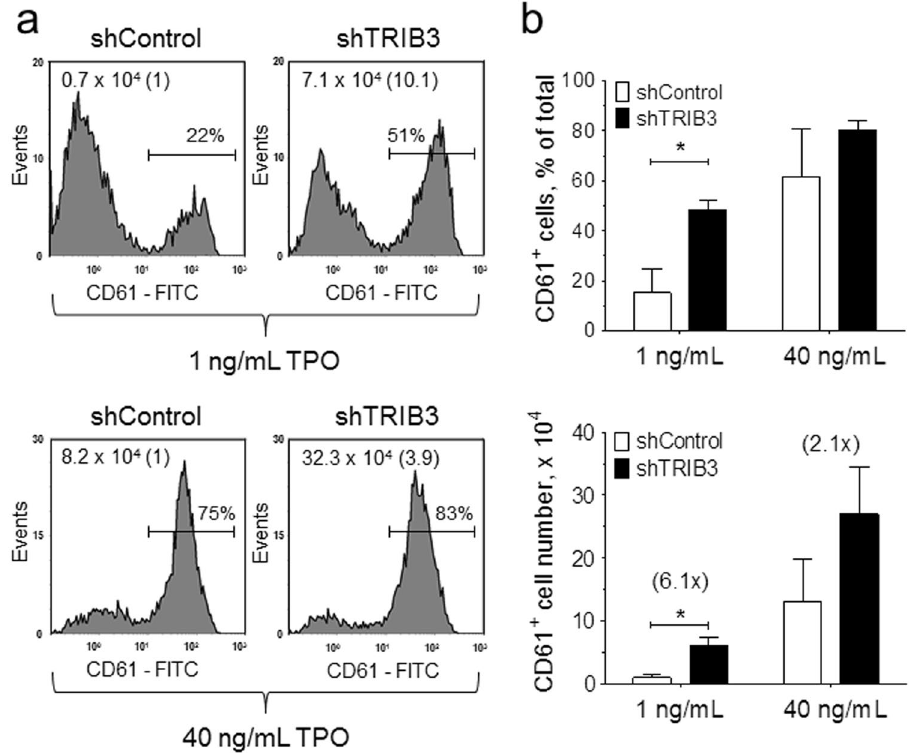
Figure 4. TRIB3 silencing potentiates the megakaryocytopoietic activity of TPO. shRNA-transduced primary haematopoietic cells were grown as in Fig. 3 with either 1 or 40 ng/mL TPO and then analysed for CD61 expression. ( a ) Representative histogram plots display the percentages and total number of CD61 + cells in the cultures; the fold change in the number of CD61 + cells relative to shControl is shown in brackets. ( b ) Results of two independent experiments are presented as mean ± SD. * P <